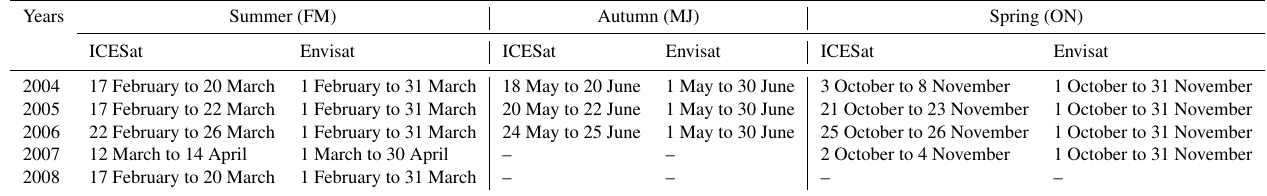
Table 1. ICESat operating periods and Envisat periods used for the comparisons. The three seasons are divided according to the ICESat operating periods. Note that ON is October–November, FM is February–March and MJ is May–June.